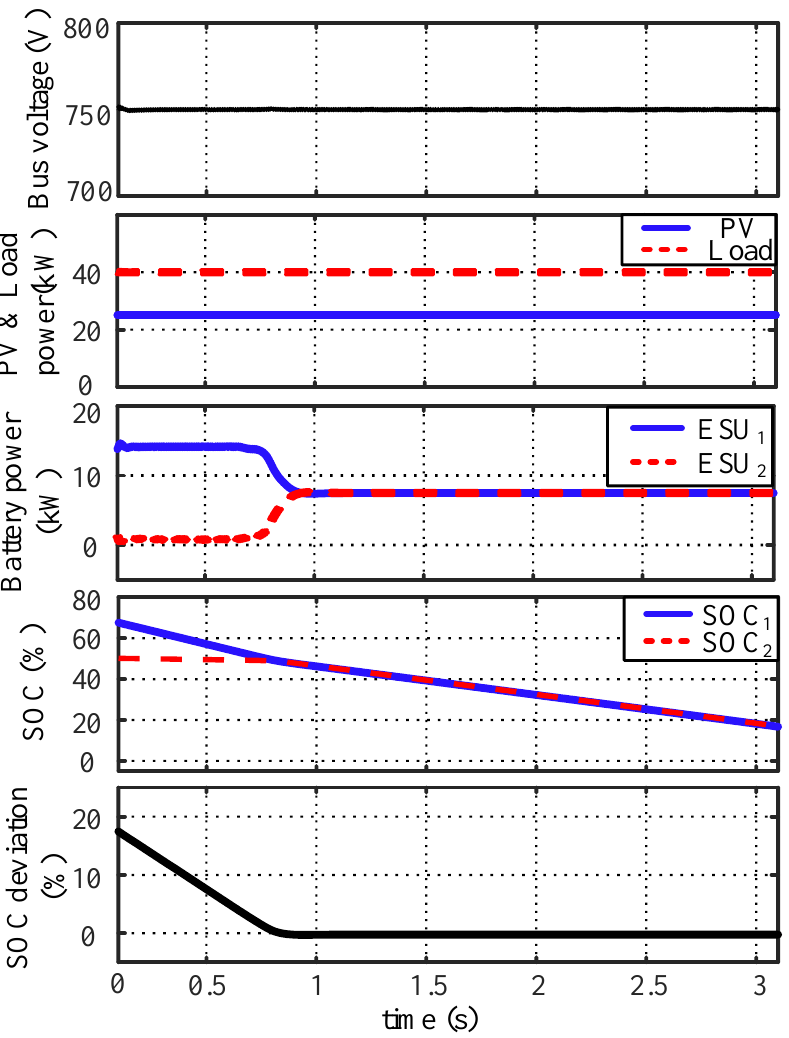
Figure 6. Waveforms of P ≤ P dmax in